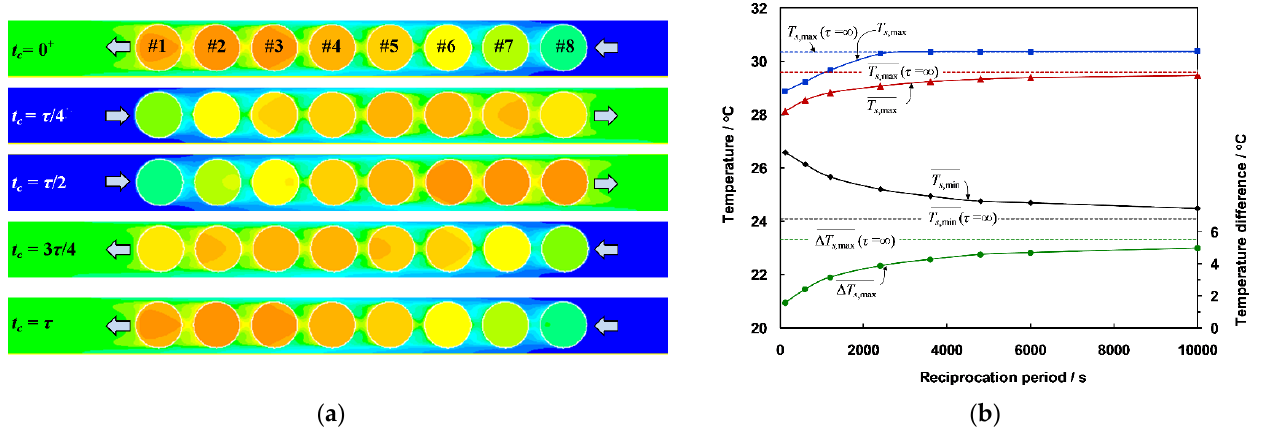
Figure 19. ( a ) Spatio-temporal profile of temperature contour over a full cycle. ( b ) The effect of the reciprocating period on the maximum cell temperature and the pack temperature differential. Reprinted with permission from [35]. Copyright 2011